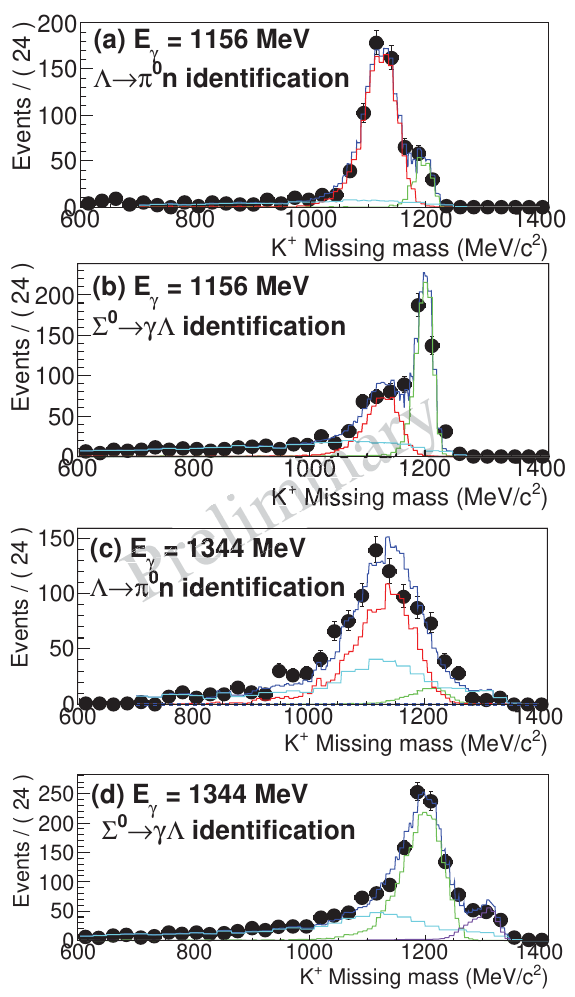
Figure 15. Missing mass recoiling from forward K + candidates (black points) for two di ff erent photon beam energies and selec- tion criteria to either accentuate the K + Λ or K + Σ 0 signal. The spectra are fitted with e + background (described in the text), sim- ulated K + Λ , K + Σ 0 and K + Σ 0 (1385) (cyan, red, green and purple lines respectively). The blue line is the summed fit.